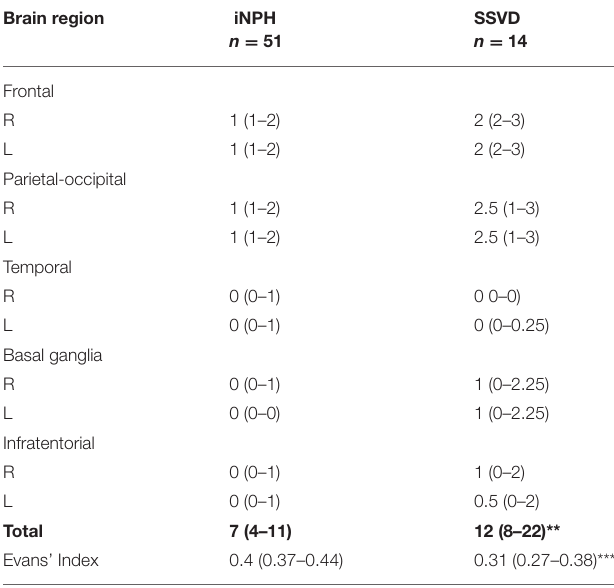
TABLE 3 | Age-related white matter changes (ARWMC) scores and Evans’ Index in patients with iNPH and SSVD. Brain region iNPH n =